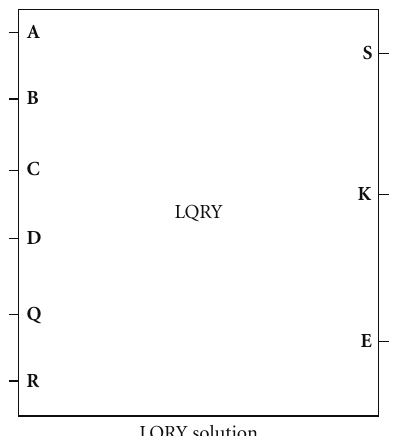
Table 2: Main simulation parameters. Figure 10: LQR Solver Simulink Block [18]. This routine solves the complete algebraic Riccati equation accepting the input matrices: A (dynamics matrix), B (control matrix), C (state-output mapping matrix), D (control-output mapping matrix), and Q and R weighting matrices. The outputs are the LQR gain matrix, K , which is the solution to the associated algebraic Riccati equation, the matrix S , and a two-dimensional vector, E , whose first element indicates an error when it is greater than zero or a somewhat unreliable result when it is negative. The second element of E is the condition number of the R